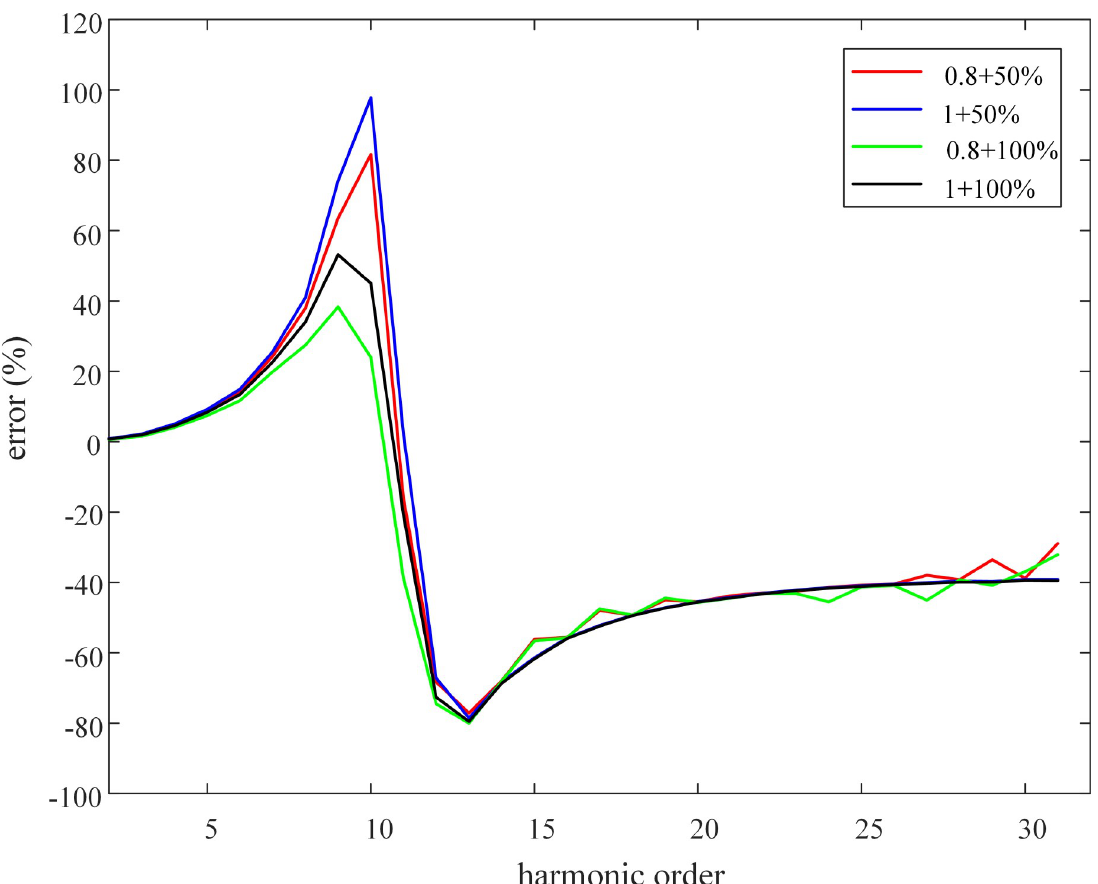
Fig 13. Harmonic voltage measurement error of the 35-kV CVT.